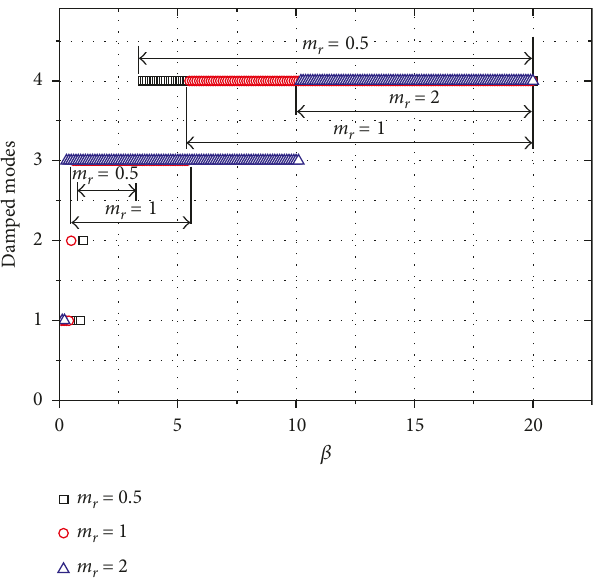
Figure 5: Damping mode capable of reaching maximum rock fracture displacement u m given the piston-to-bit mass ratio m r and β . 1: overdamped mode, 2: critically damped mode, 3: underdamped mode, 4: special underdamped mode.